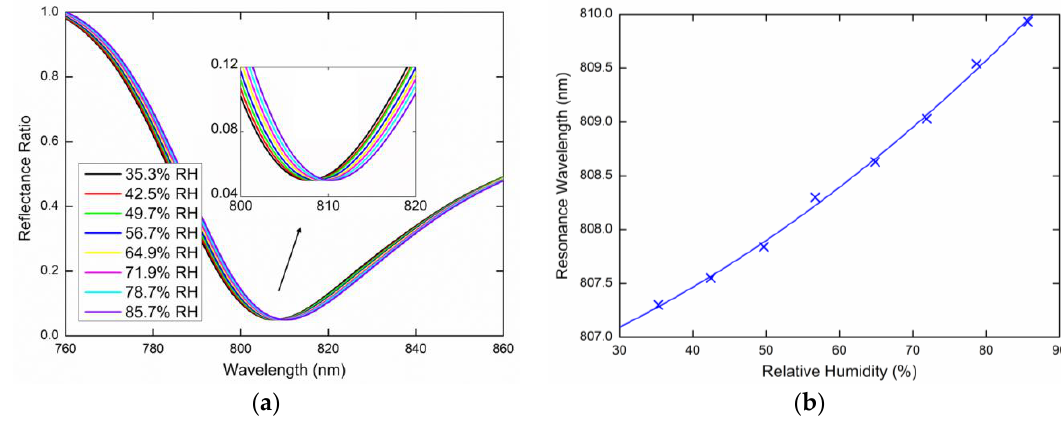
Figure 11. Measured spectral reflectance ratio 𝑅 45 (𝜆) / 𝑅 𝑠 (𝜆) for the external angle of incidence 𝛼 = 20.6° ( a ), the resonance wavelength as a function of the RH with a second-order polynomial fit ( b ).